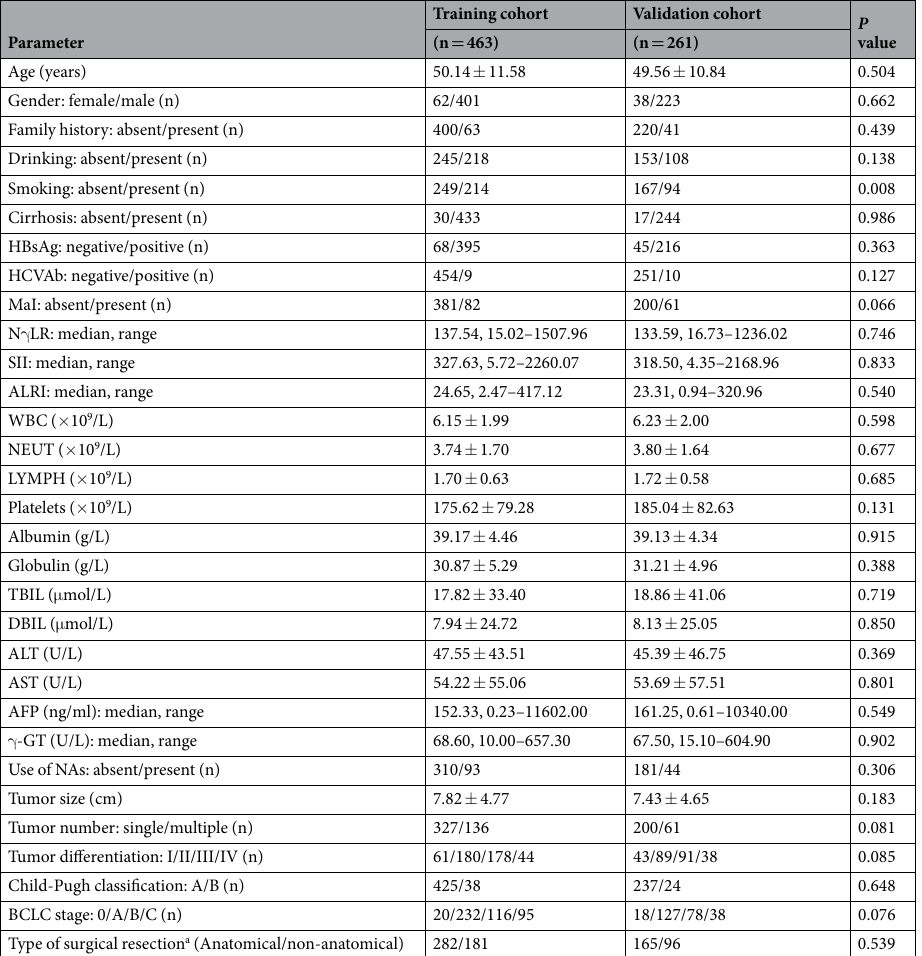
Table 1. Clinical and biochemical data of examined patients. a Anatomical resection includes hemihepatectomy, sectorectomy, and segmentectomy; non-anatomical resection includes limited resection and tumor enucleation. n, number of patients; HBsAg, hepatitis B surface antigen; HCVAb, hepatitis C virus antibody; MaI, microvascular invasion; N γ LR, neutrophil cell count times γ -glutamyl transpeptidase to lymphocyte count ratio; SII, systemic immune-inflammation index; ALRI, aspartate transaminase to lymphocyte ratio index; WBC, white blood cell; LYMPH, lymphocyte count; TBIL, total bilirubin; DBIL, direct bilirubin; ALT, alanine aminotransferase; AST, aspartate aminotransferase; AFP, alpha-fetoprotein; γ -GT, γ -glutamyl transpeptidase; NAs, nucleoside analogues; BCLC, barcelona-clinic liver